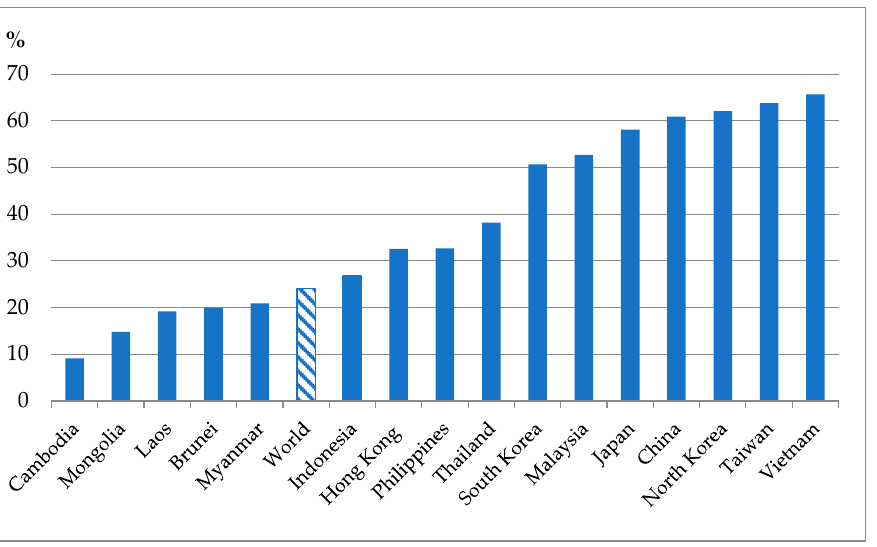
Figure 5. Percentage of arable land equipped for irrigation in East and Southeast Asian economies, 2015–2017 (Source: based on data from [4]). Note: data on percentage of arable land equipped for irrigation for Singapore is not